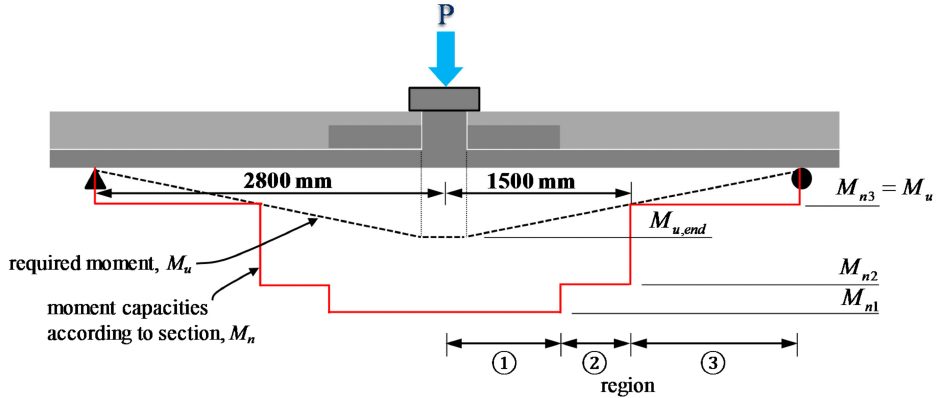
Figure 12. Moment diagram and moment capacity of the NFW